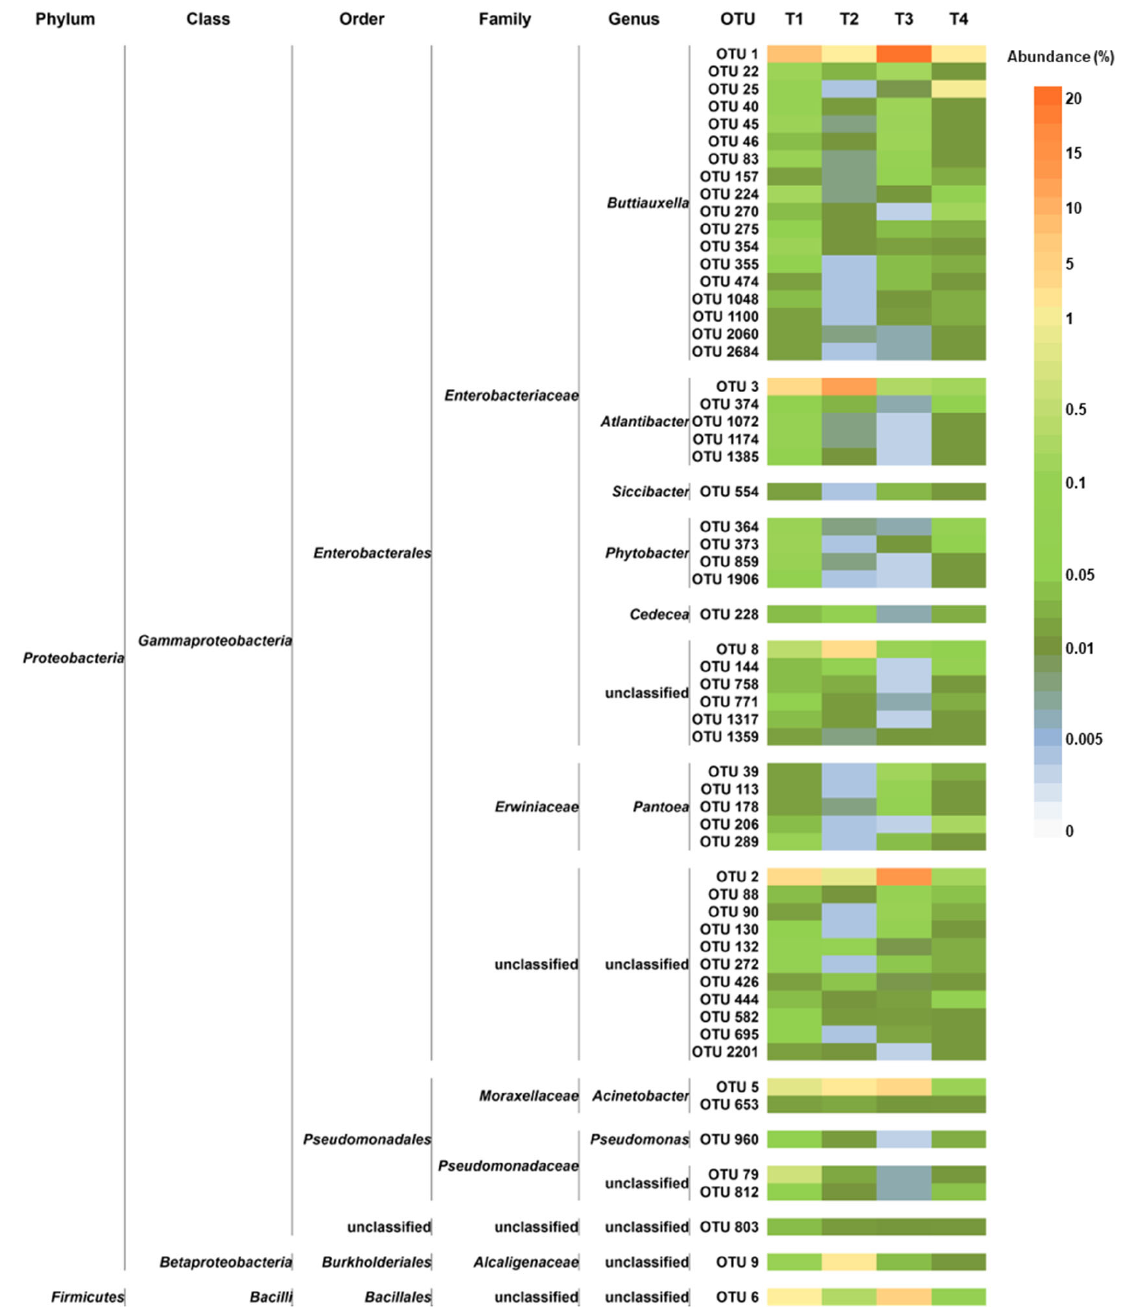
Figure 6. Distribution of the core microbiota OTUs across the studied experimental conditions. For each OTU, the taxonomic annotation is provided. T1: WT/OF, T2: WT/CF, T3: SB/OF, T4: SB/CF.